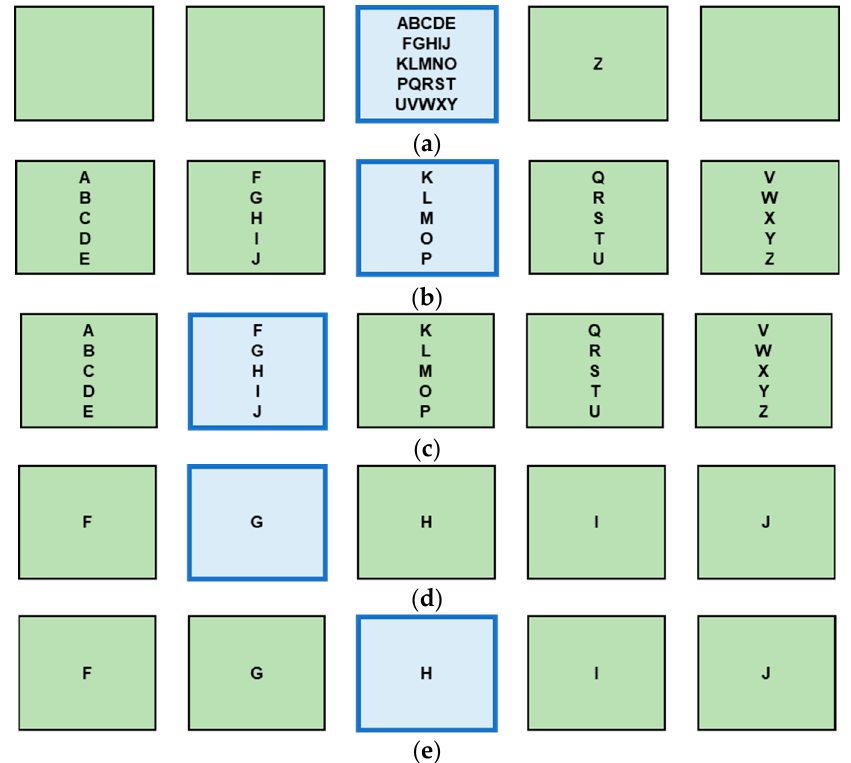
Figure 11. Example of key typing sequence of character ‘H’: ( a ) selection of middle block (light blue block) by gazing operation; ( b ) split of letters into five blocks; ( c ) selection of the desired block by moving one’s eye 20° to the left; ( d ) split of letter box again; ( e ) typing of letter ‘H’ by biting once action.